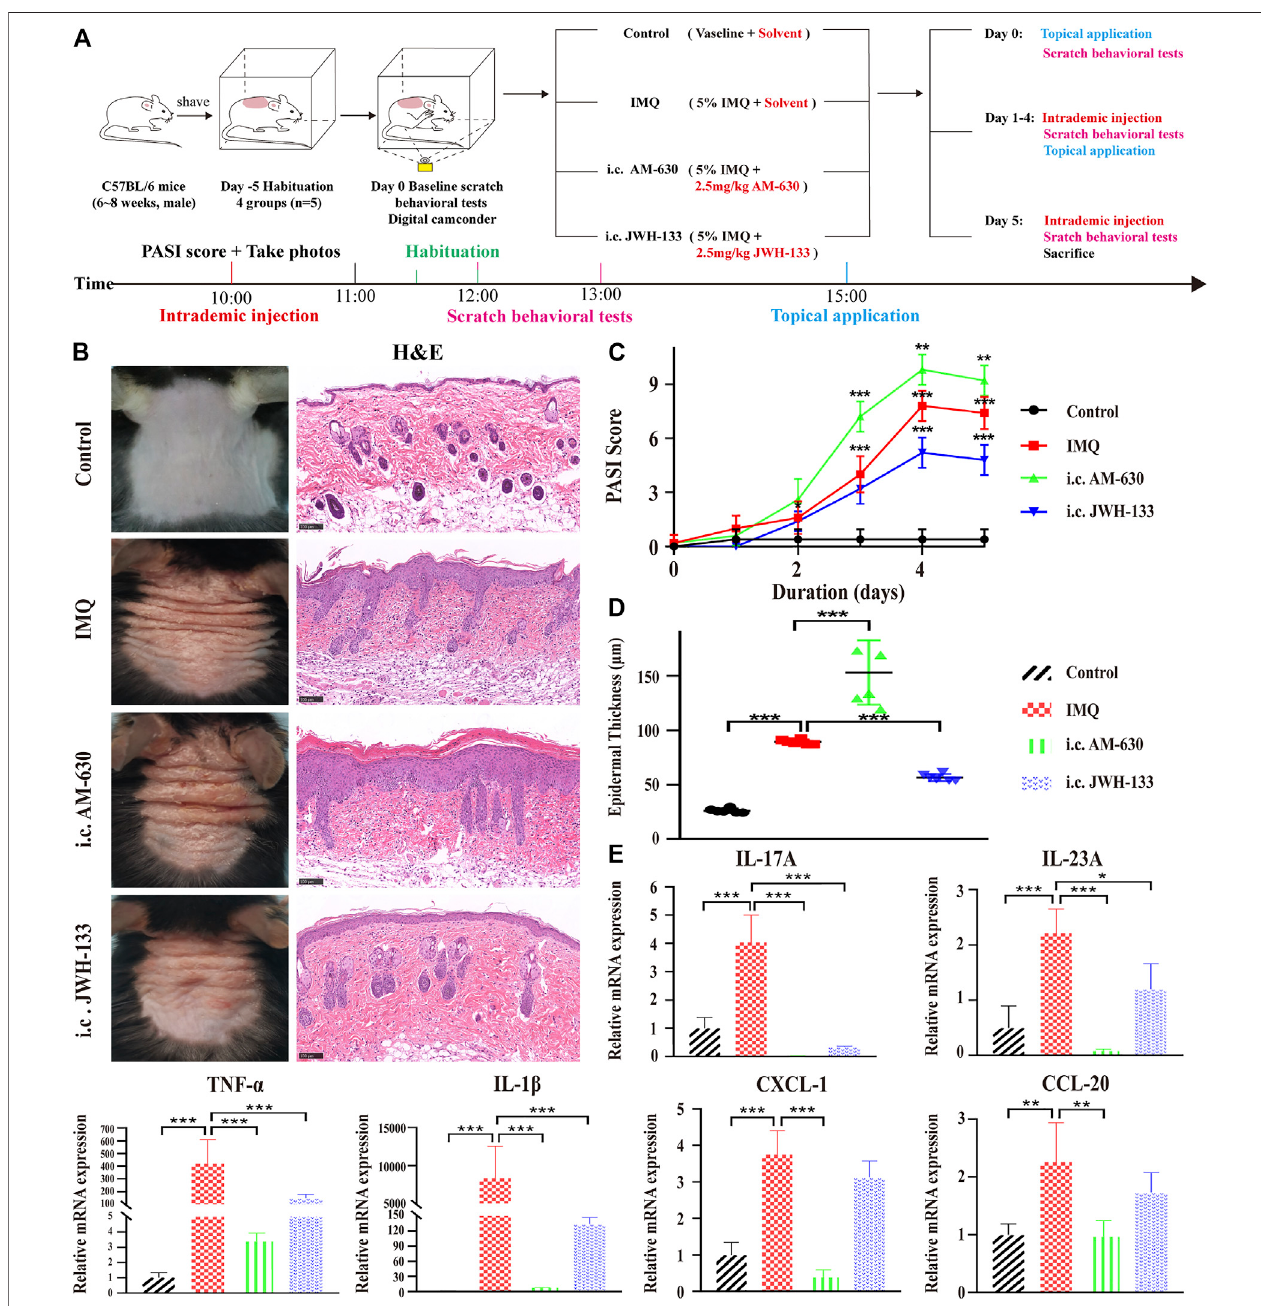
FIGURE 4 | The selective agonist of CB2R, JWH-133, could alleviate PsD in IMQ-induced mice. (A) Schematic diagram of the animal experiment protocol for the control,IMQ,i.c.AM-630andi.c.JWH-133groups( n =5). (B) RepresentativemacroscopicviewandH&Estainingofcross-sectionalslicesofthedorsalskinofC57BL/6 miceonthe fi fthday.Scalebarrepresents100 μ m. (C) Dailyassessmentofepidermalerythema,scales,andthickeningofthedorsalskin.ThePASIscorewascalculated by adding the scores of three independent criteria (ranging from 0 to 12). (D) The epidermal thickness of the dorsal skin on the fi fth day was measured by four randomly selected fi elds per section of each mouse. (E) The mRNA expression levels of IL-17A, IL-23A, TNF- α , IL-1 β , CXCL-1 and CCL-20 were measured by qRT- PCR. Error bars represent mean ± SD. ( n = 5 for each group). * p < 0.05, ** p < 0.01, and *** p < 0.001 when compared. All the assays were repeated three times with consistent